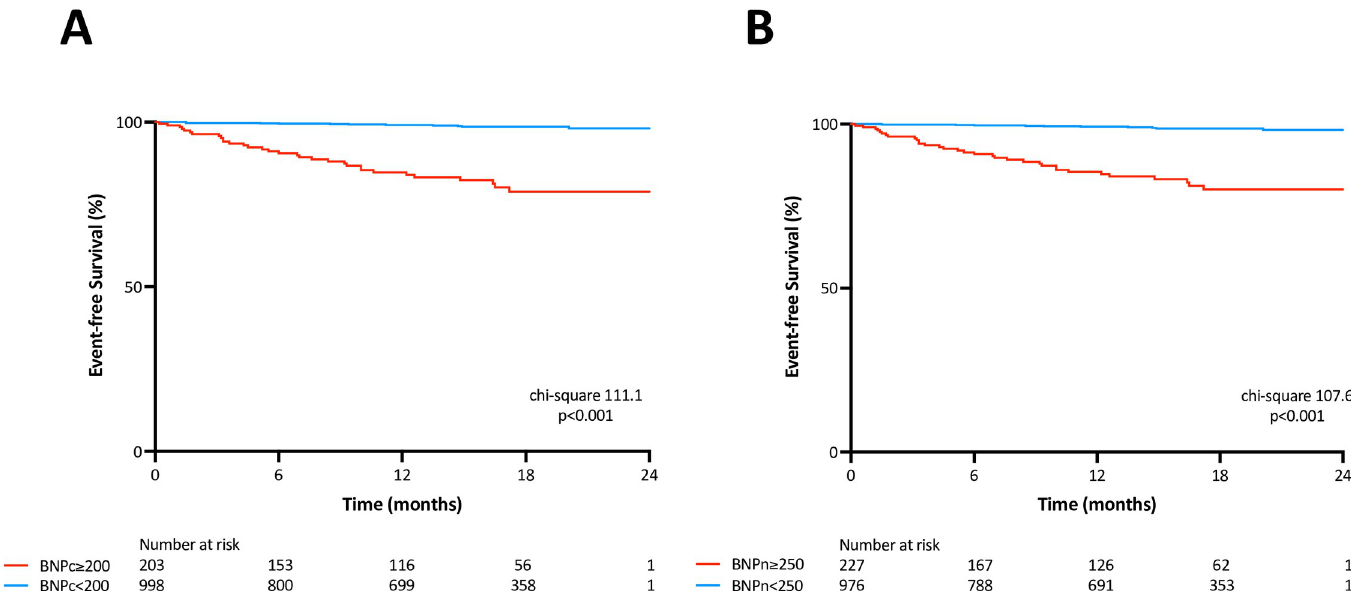
Fig 3. Kaplan-Meier survival analysis for cardiac events. A: Brain natriuretic peptide by the conventional method (BNPc), B: Brain natriuretic peptide by a novel method (BNPn). Patients were classified into two groups according to the cut-off values. Note that different cut-off values were employed, 200 ng/L for BNPc and 250 ng/L for BNPn.